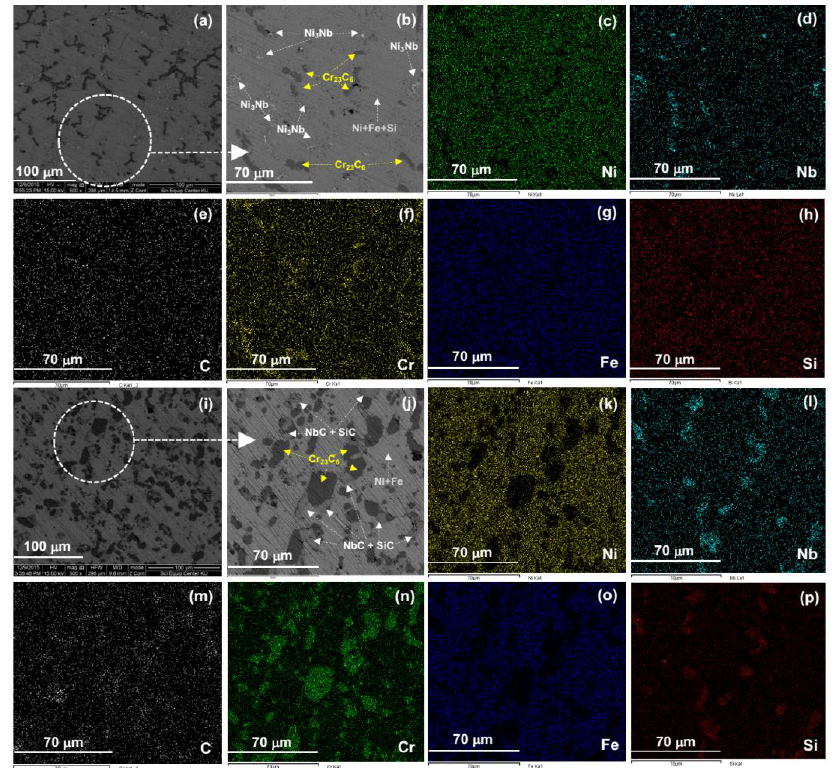
Figure 4. BEI and EDS mapping of ( a – h ) Specimen No. 1 (new); and ( i – p ) Specimen No. 2 (used).